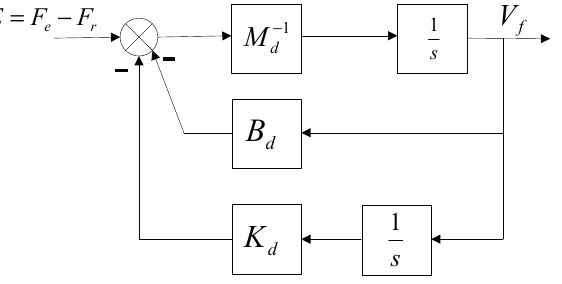
Figure 3. The structure diagram of the impedance control